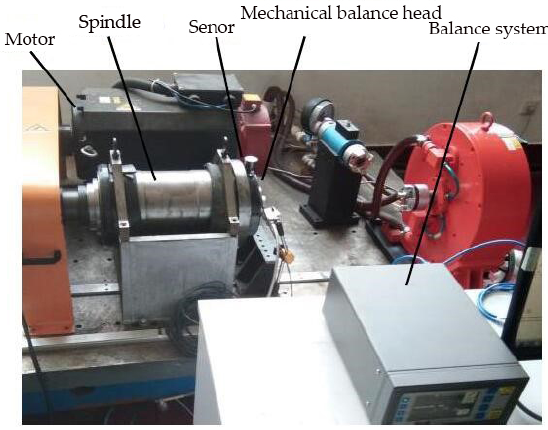
Figure 6. Experiment platform.